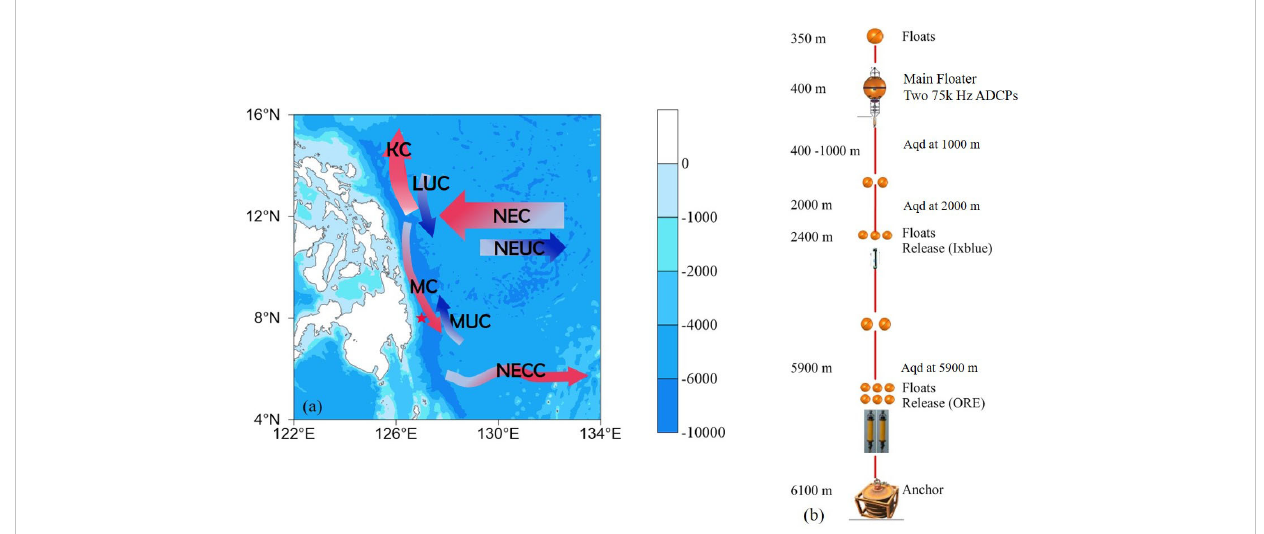
FIGURE 1 (A) Bottom topography and surface (red arrows) and subsurface (blue arrows) currents around Philippines. NEC, North Equatorial Current; NEUC, North Equatorial Current; MC, Mindanao Current; MUC, Mindanao Undercurrent; NECC, North Equatorial Counter Current; KC, Kuroshio Current; LUC, Luzon Undercurrent. The red triangle denotes the mooring at 8°N, 127°E. (B) Vertical structure of the mooring